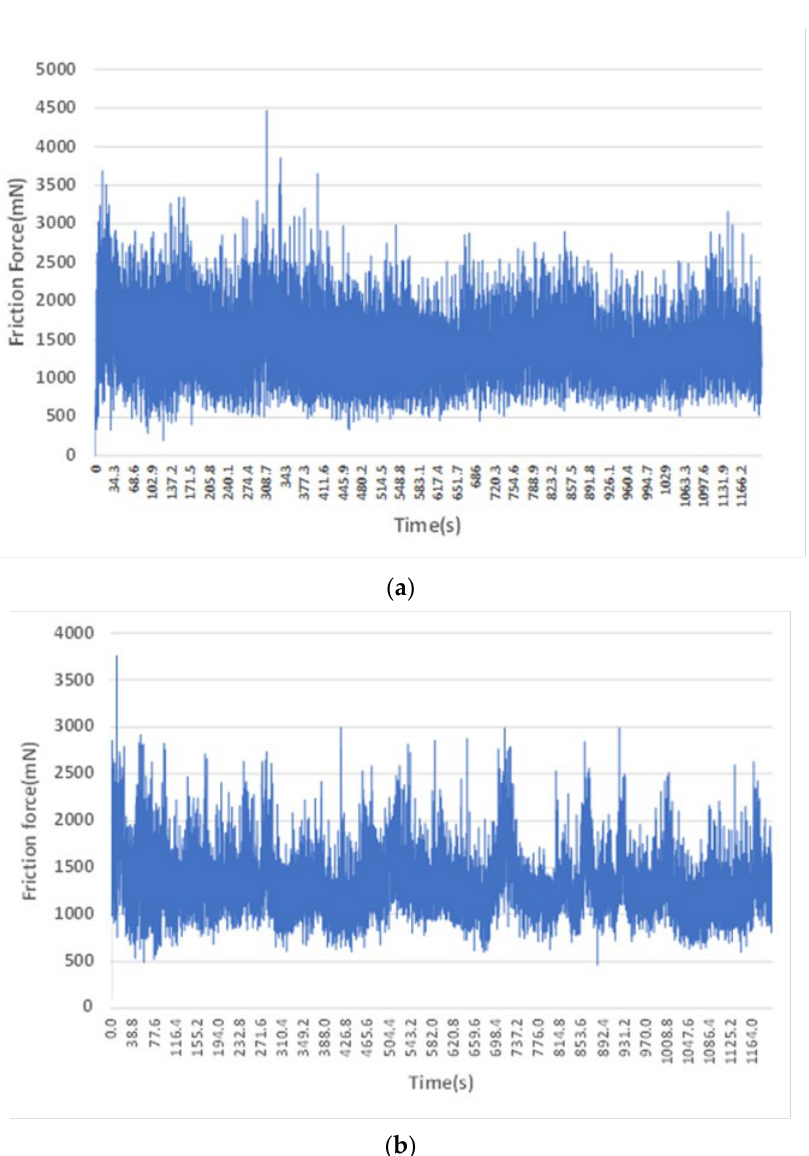
Figure 9. Ball-on-disk test results for surfaces of ( a ) pure Al and ( b ) CNT-rich surfaces of FGMs with the rotation speed of 150 rpm.